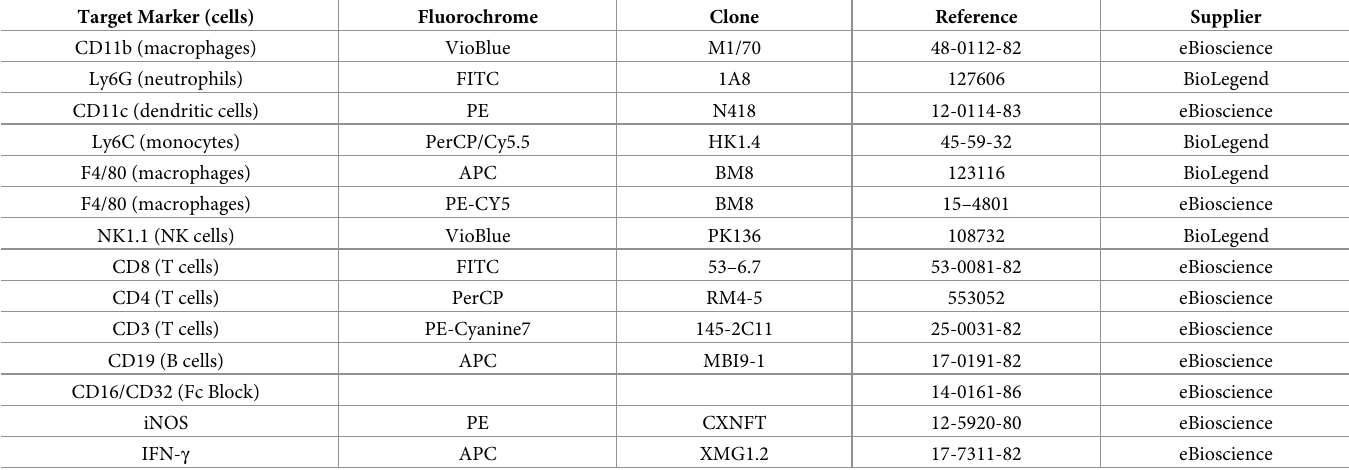
Table 1. Antibodies used for flow